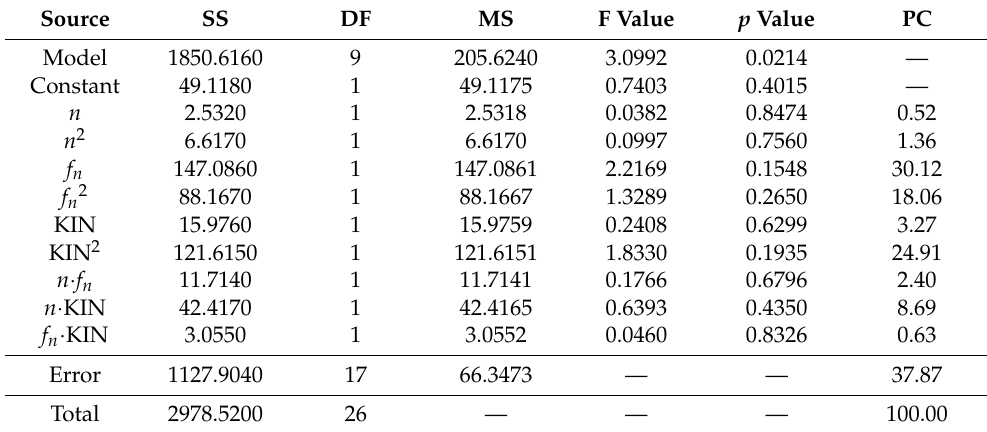
Table 7. ANOVA results for the straightness error.